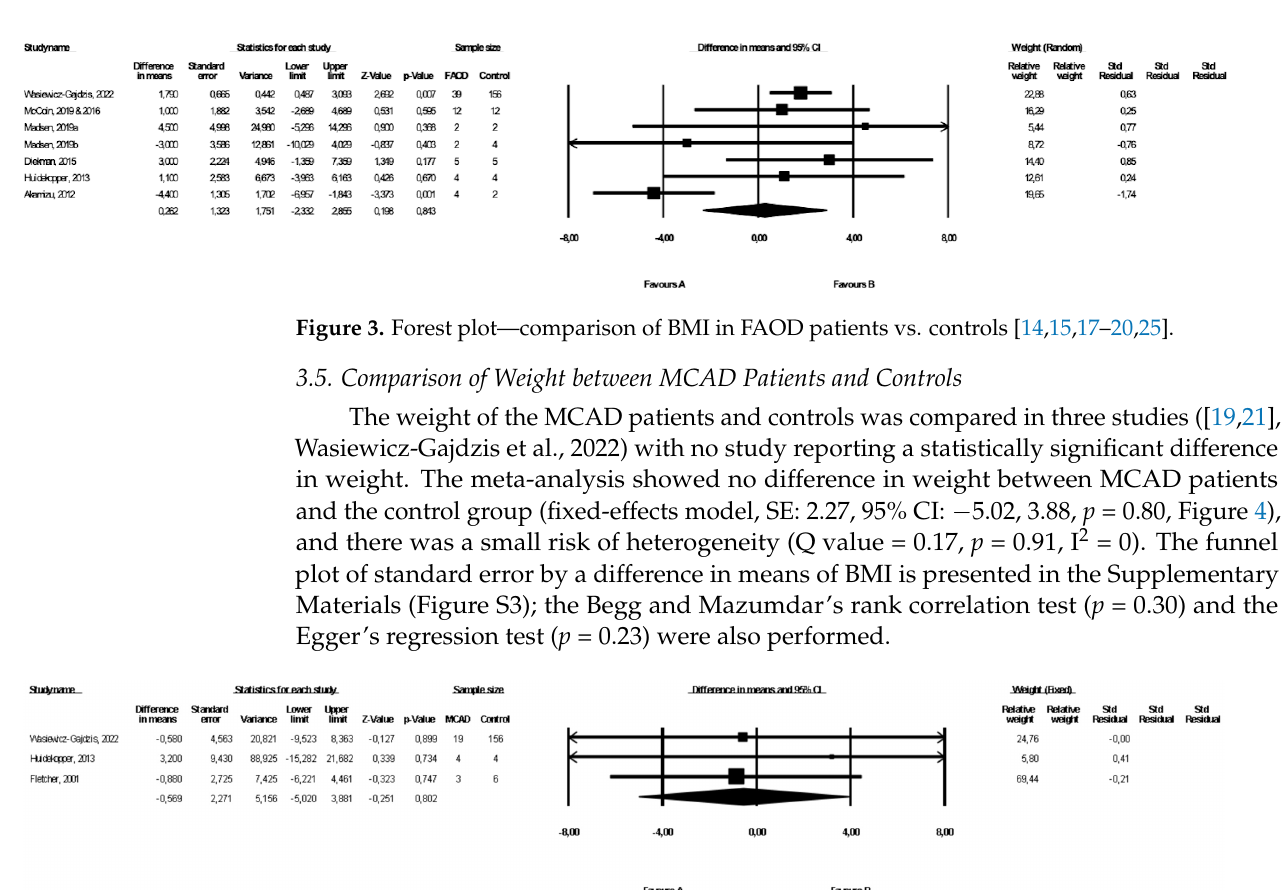
Figure 4. Forest plot—comparison of bodyweight in MCAD patients vs. controls [19,20].